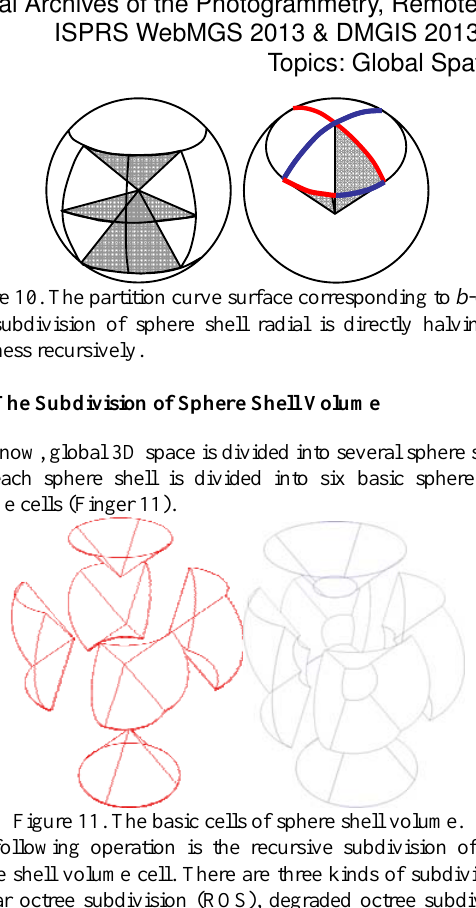
Figure 16. AOS near equator